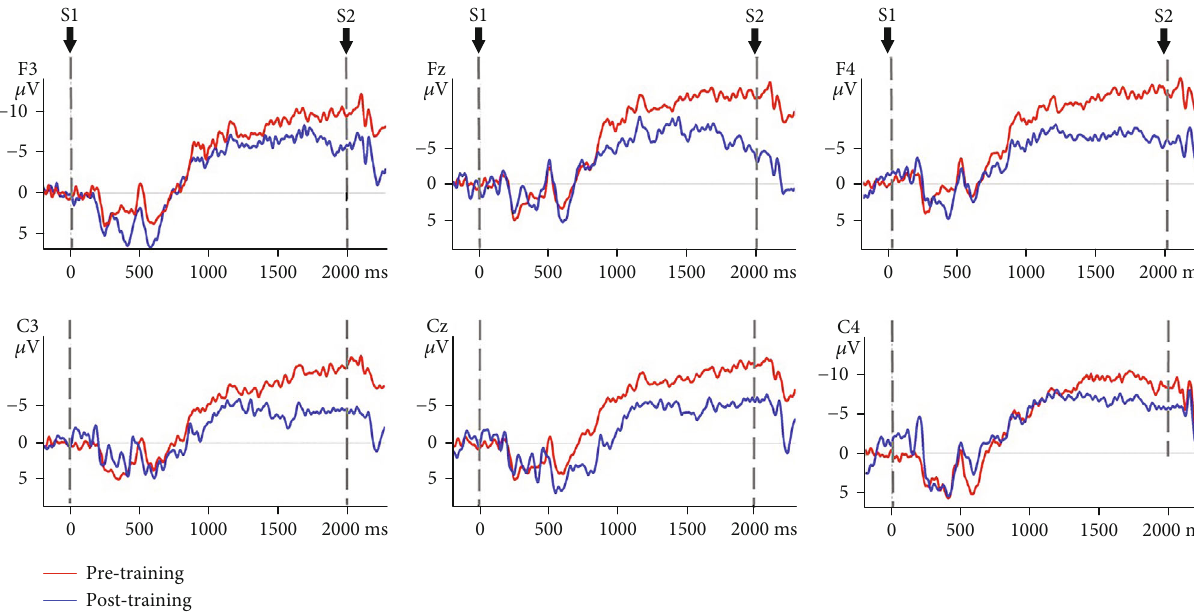
Figure 6: CNV amplitudes of the VR group during paretic hand movement. Negative is plotted upwards. Note: the 200ms epoch prior to the S1 onset was the baseline CNV amplitude. The onset is at 0ms point and is the S1 trigger